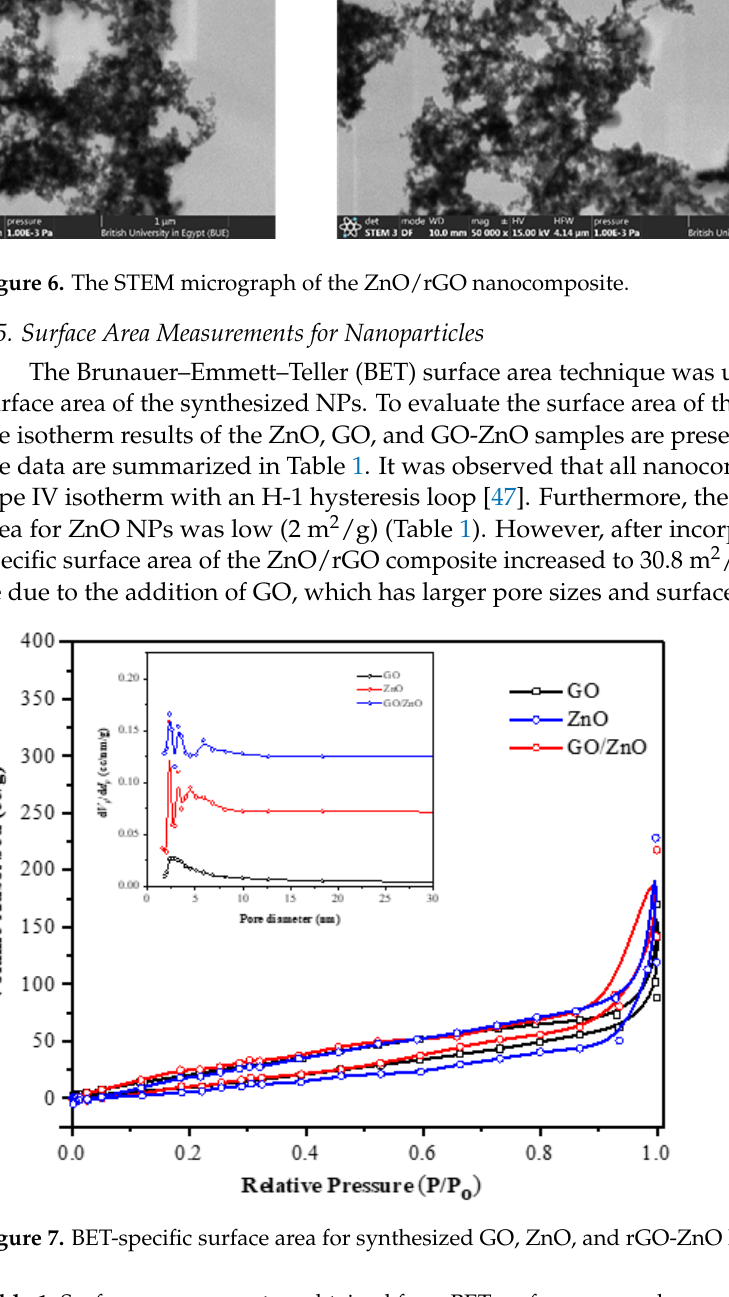
Figure 6 . The STEM micrograph of the ZnO/rGO nanocomposite.